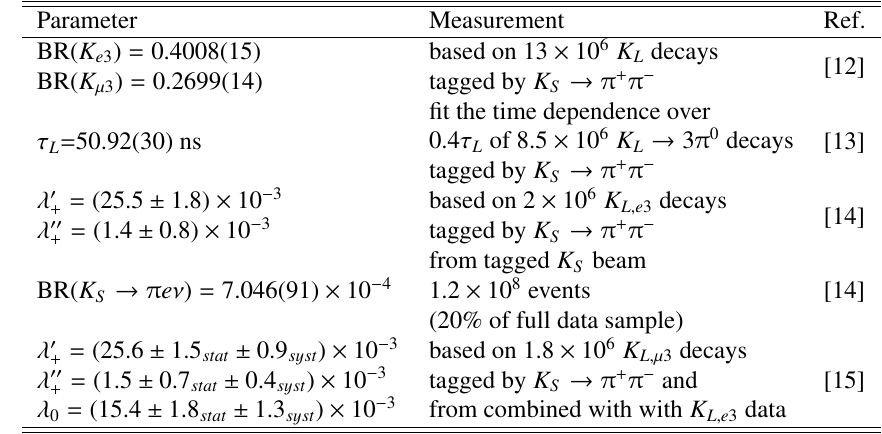
Table 1. Summary of KLOE results from neutral kaons useful for V us